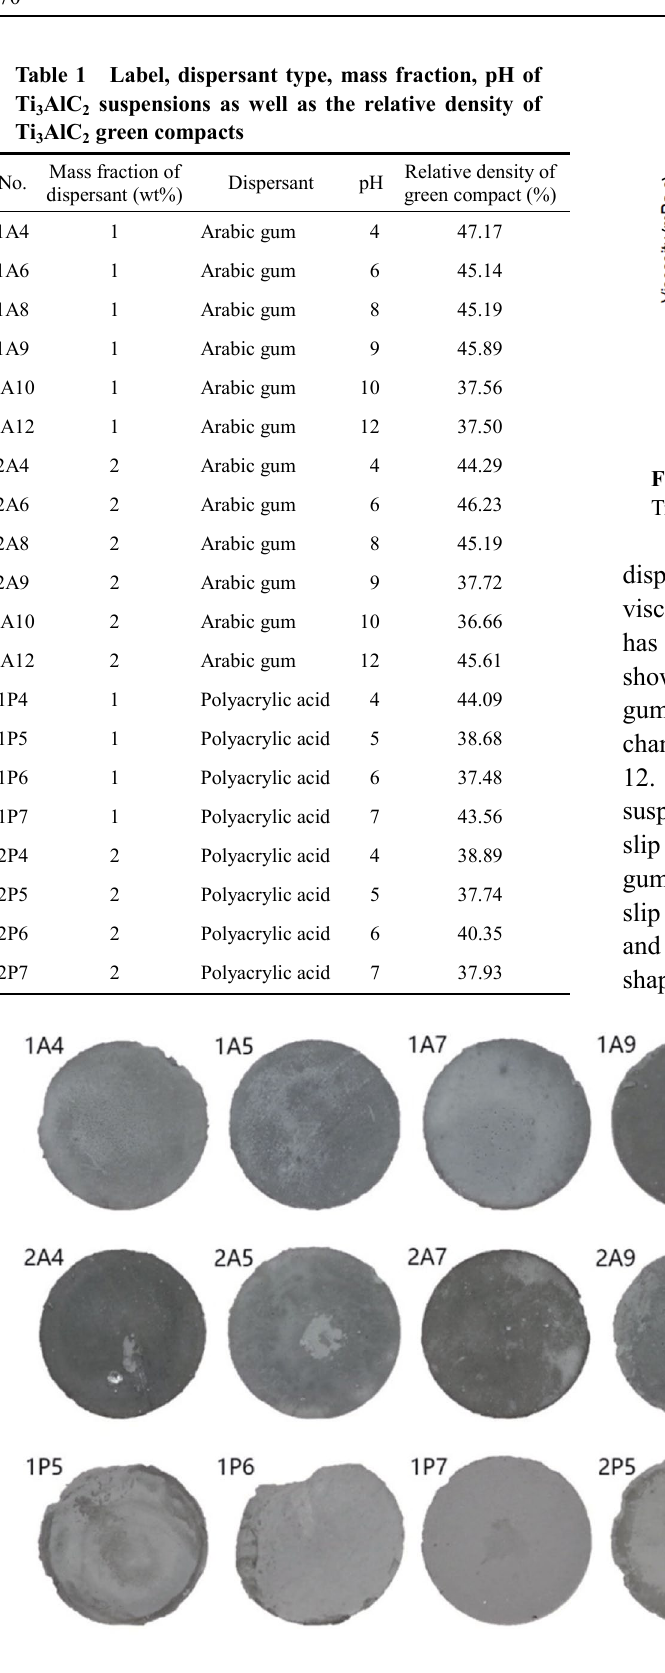
Fig. 4 Front view photographs of slip-casted Ti 3 AlC 2 green